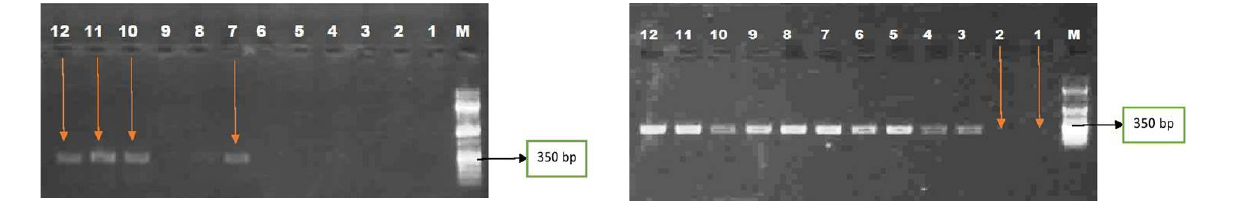
Fig. 8. Gel image of trnL-F primer amplified Inula gDNA’s